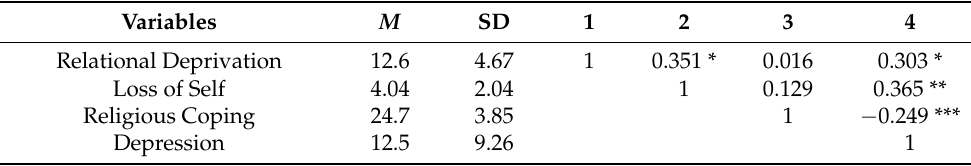
Table 3. Descriptive statistics and Pearson’s correlation analysis ( n = 50).